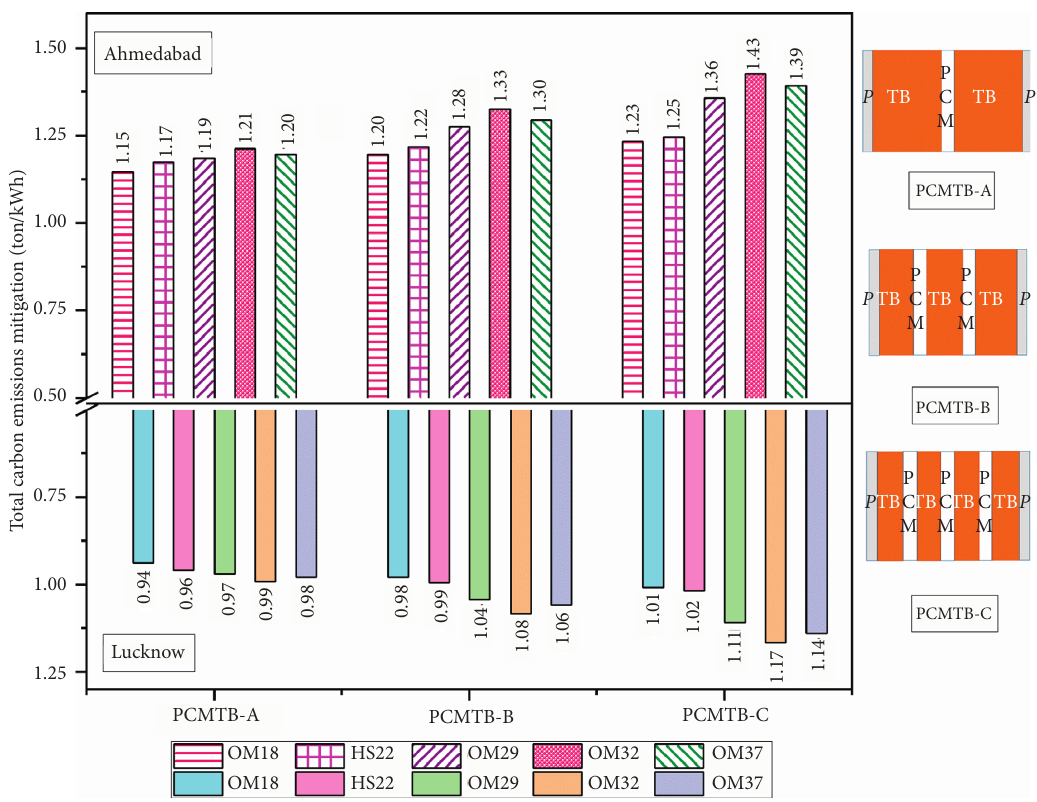
Figure 8: Carbon emission mitigation of terracotta brick buildings integrated with PCMs in Ahmedabad and Lucknow